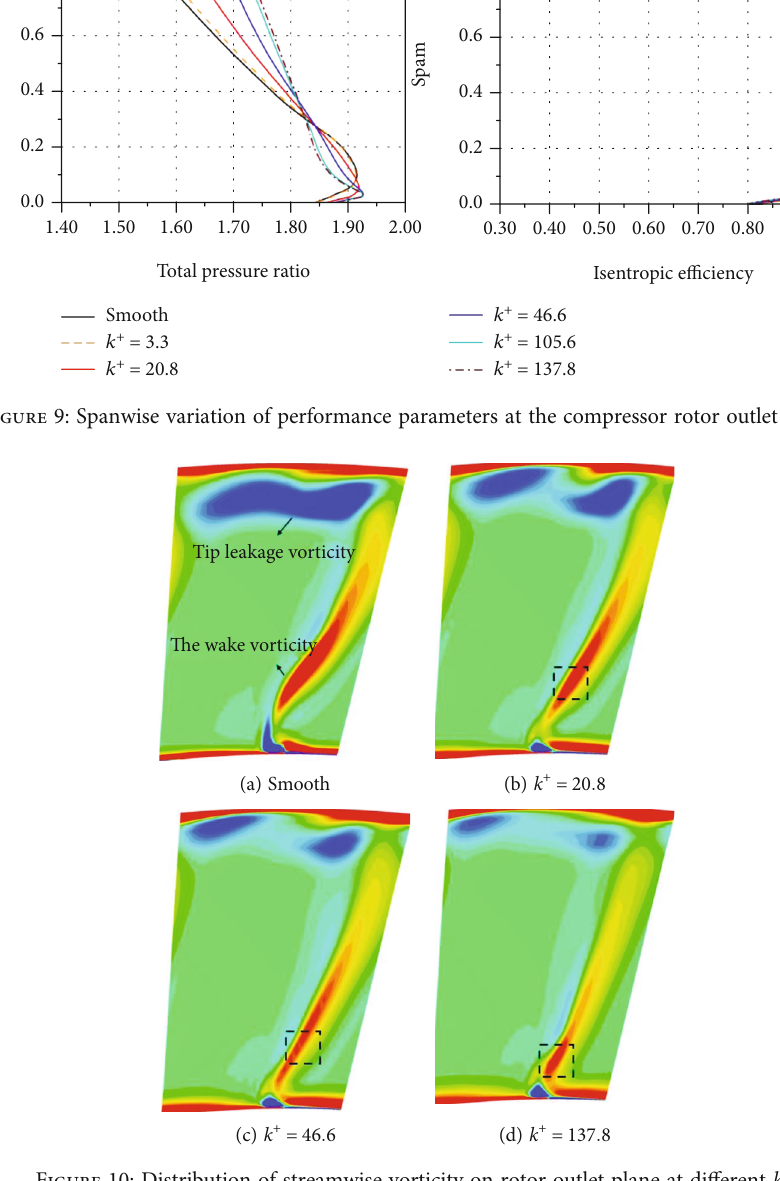
Figure 10: Distribution of streamwise vorticity on rotor outlet plane at di ff erent k +